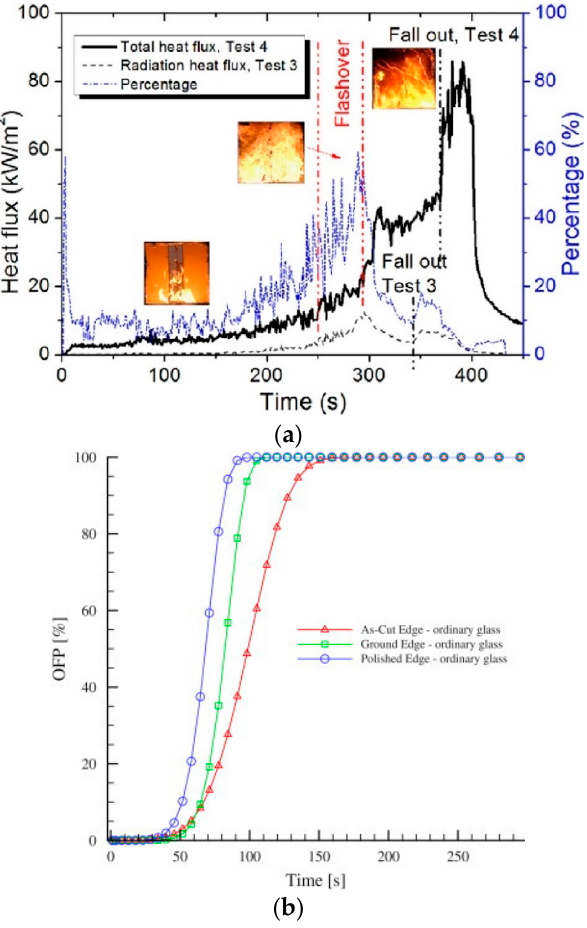
Figure 1. Analysis of thermal breakage in glass cladding: ( a ) experimental analysis of boundary effects (reproduced from [15] with permission from Elsevier, license number 4996960474361, January 2021) and ( b ) finite element numerical prediction of the probability failure for ordinary glass under radiant heating, as a function of edge finishing (reproduced from [17] with permission from Elsevier, license number 4996960742227, January